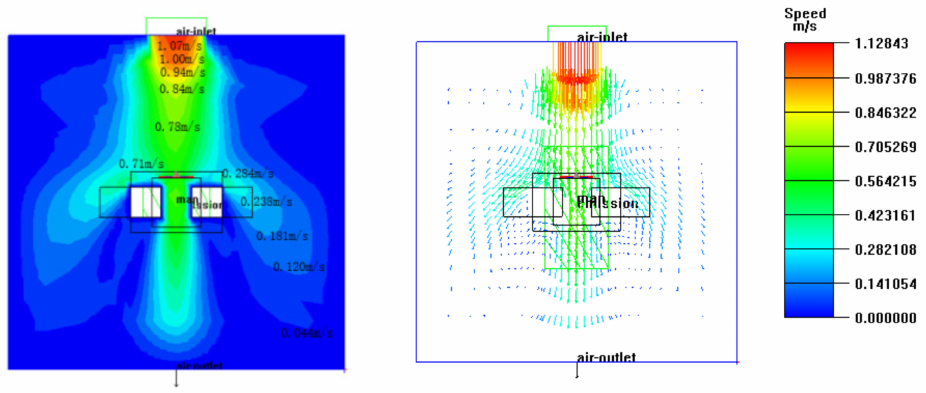
Figure 10. Cloud chart at Y = 0.15